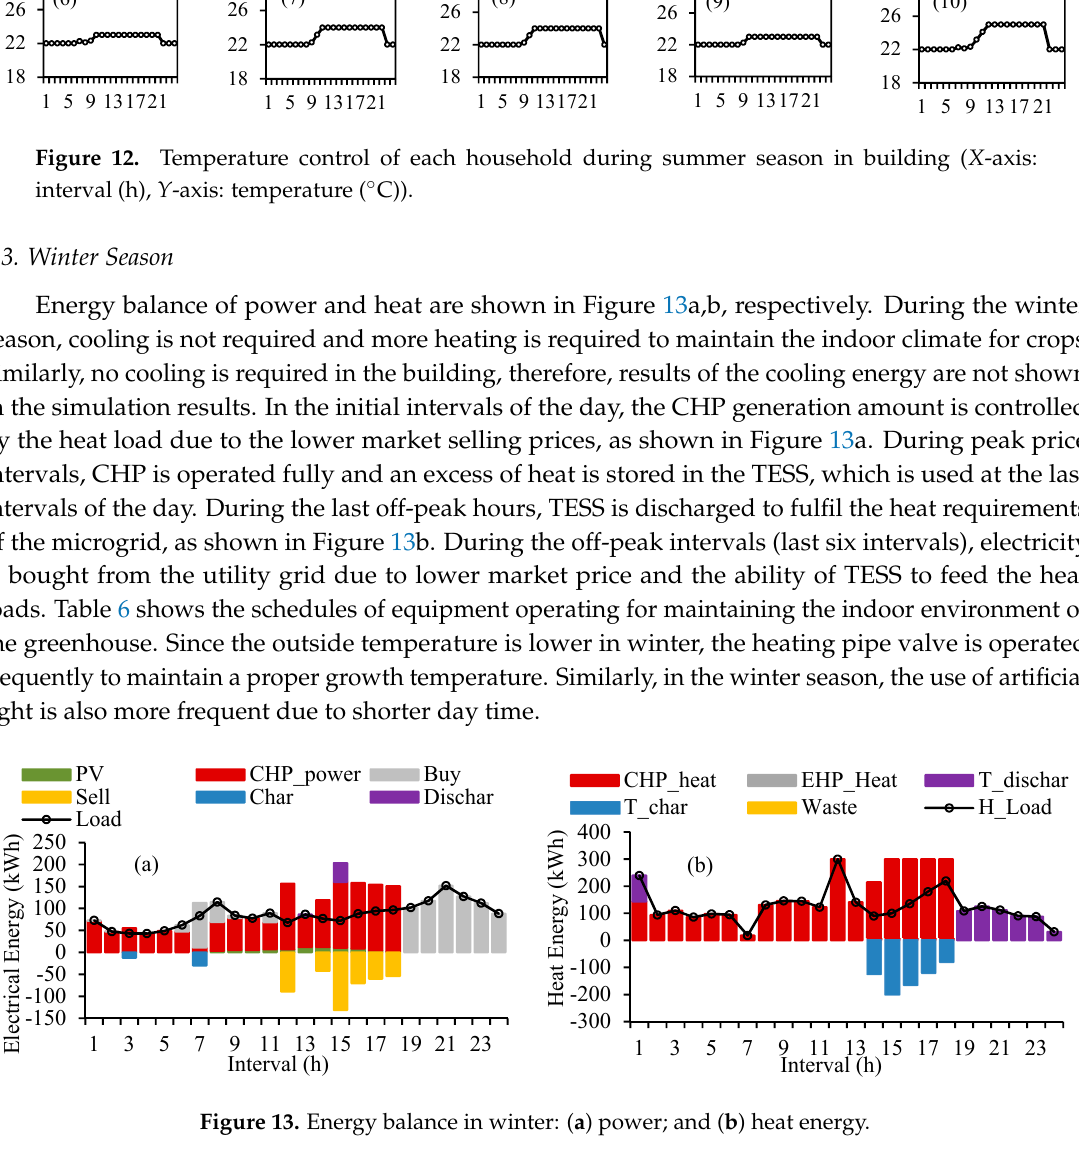
Table 6. Equipment usage for environment control during winter season in greenhouse.